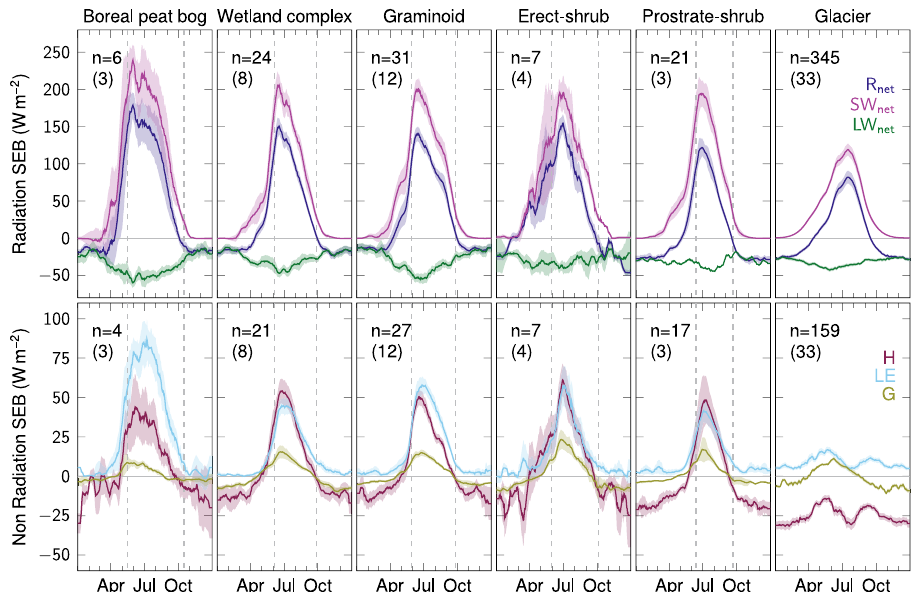
Fig.2|Seasonalitiesofradiationandnon-radiation fl uxesofthesurfaceenergy budget(SEB). Surface energy fl uxvalues (Wm − 2 ) wereaveragedforeachstudy site foreachdayofyear(DOY)acrossallyearsavailableandthenaveraged(mean±s.e.) for each DOY and smoothed (15-day moving average) for each vegetation type. Averagenumberofsiteyears(n)acrossallDOY ’ sandsurfaceenergy fl uxes,andthe number of study sites (in parentheses) are indicated in the top left corner of each fi gure. The area within the vertical gray lines represents the median snow-free period across the years 2000 – 2020 (MODIS 41 ), averaged across sites for each vegetation type. Radiation surface energy fl uxes: R net (dark blue): net radiation;